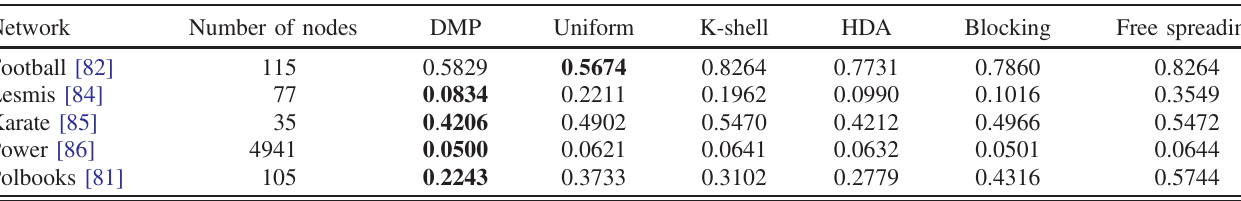
TABLE III. Comparing different deployment methods for a competitive scenario on various networks. In each network, we randomly choose 0 . 05 N nodes as seeds of process B and the same total budget for the competitive process A , where N is the number of nodes in the network. The infection parameters are α A ¼ 0 . 2 and α B ¼ 0 . 3 . The initial parameter ϵ , which forces the budget limits per node as in Eq. (F2), is initially set to 0.1 but decays exponentially with the iteration steps. The optimization procedure is iterated 10 times, and the best result is selected. The objective is to minimize the spreading of process B ; the normalized total spreading T ¼ 3 is shown. In all methods, budgets are available at time zero. Uniform allocation assumes that all the budgets are uniformly allocated to all nodes at time zero (except those infected with process B ). In free spreading, no agents are allocated for process A . In blocking, competitive agents are not infectious ( p ¼ 0 ); all the budget is used to contain the spreading of B . The best results are denoted by bold font.